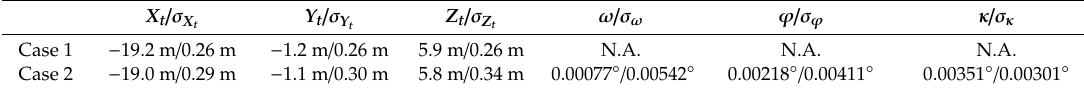
Table 3. Transformation parameters and standard deviation obtained using 15